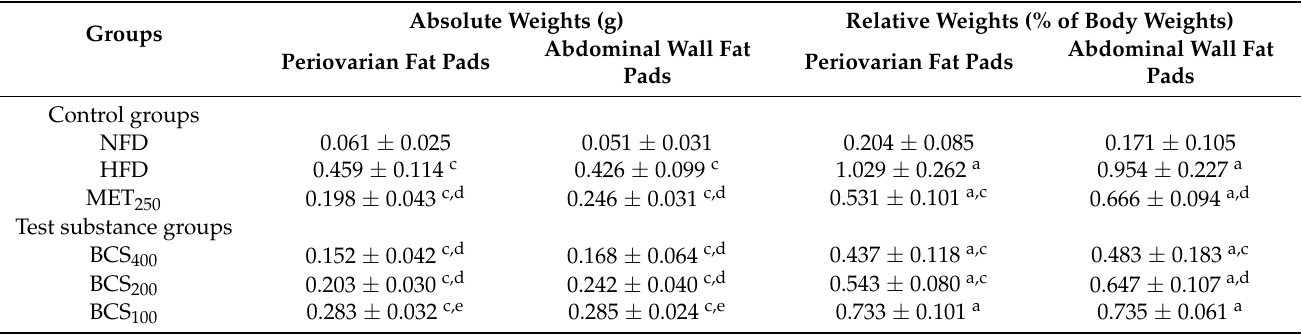
Table 1. Absolute and relative weights of fat pads in the HFD- and NFD-supplied